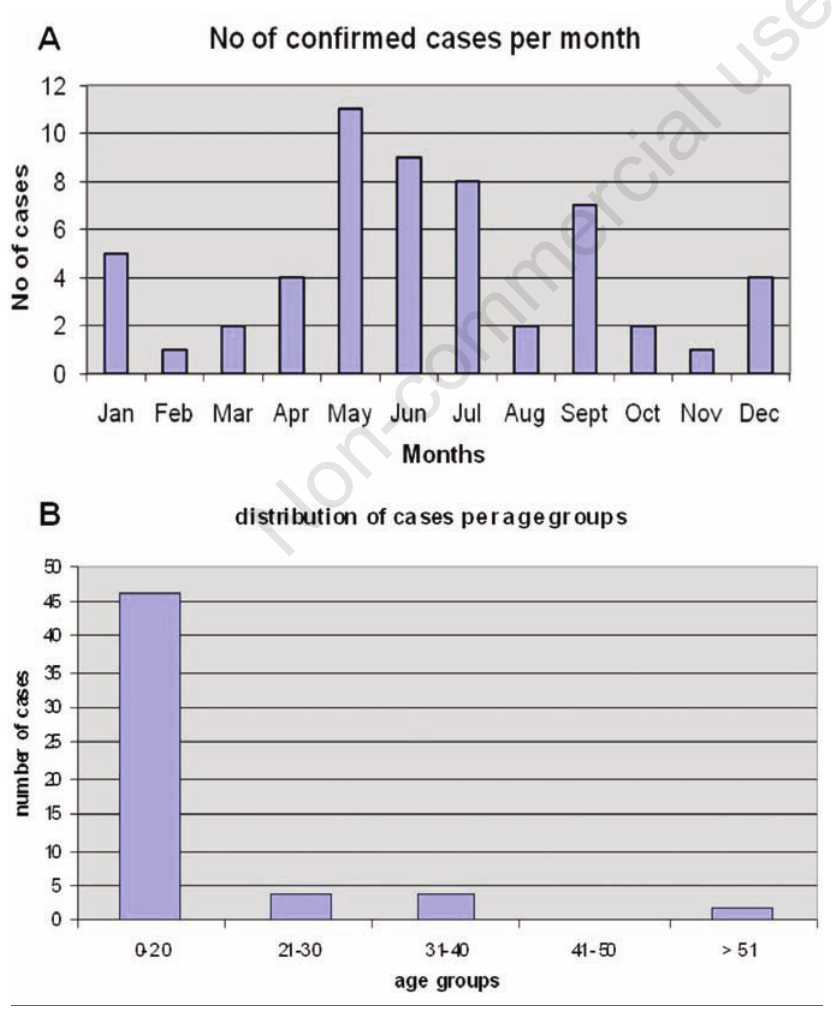
Figure 1. Distribution of Cat-scratch disease cases by (A) month and (B)